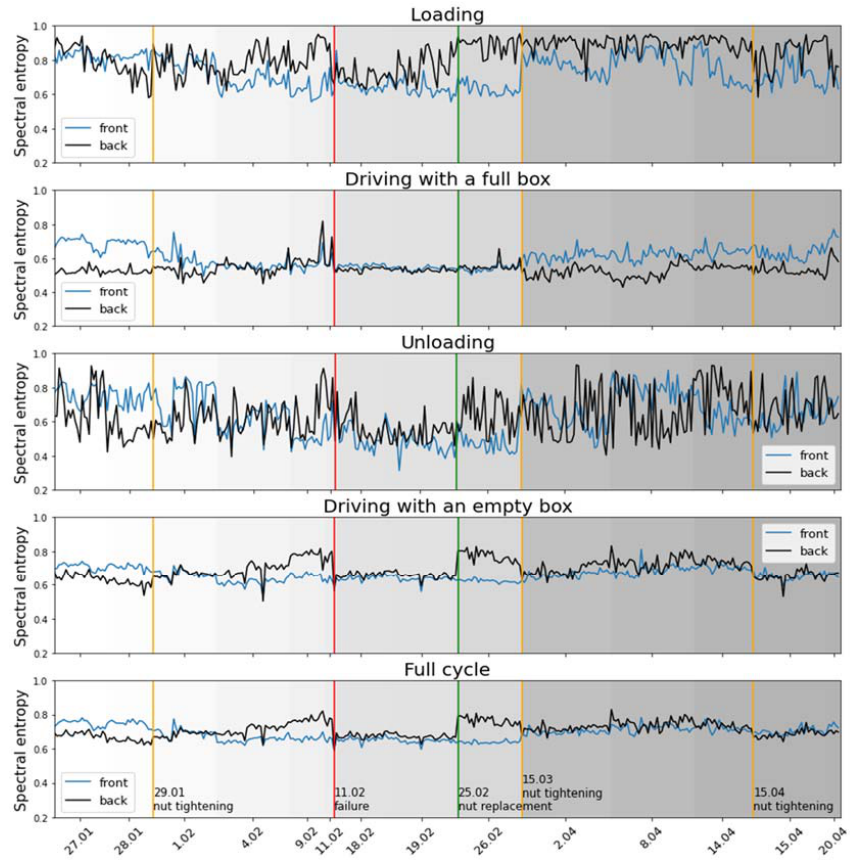
Figure 8. Spectral entropy of the Z axis accelerometer calculated once per cycle and a component operation for 14 selected days for machine